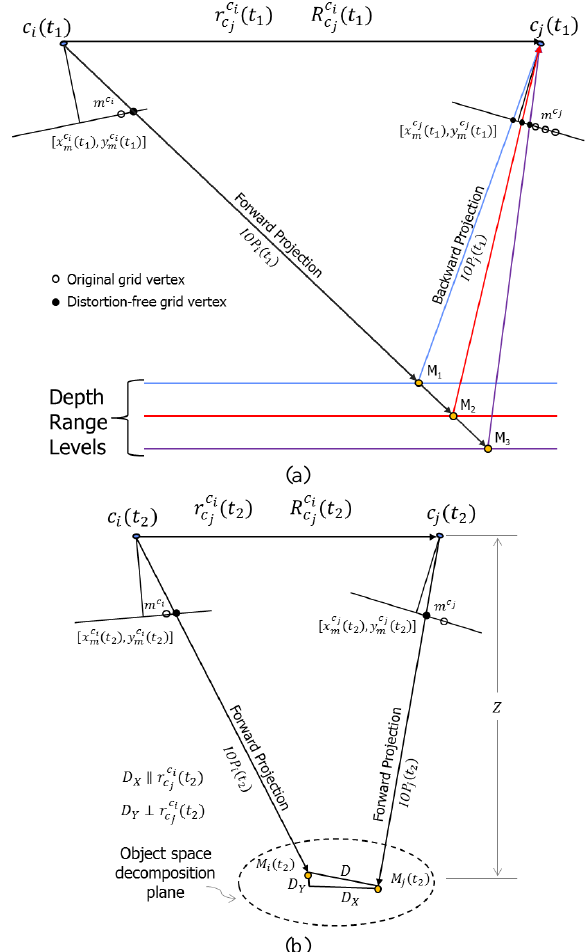
Figure 2. Forward and backward projections with the first set of system calibration parameters (a); forward projections with the second set of system calibration parameters for quantifying the object space parallax